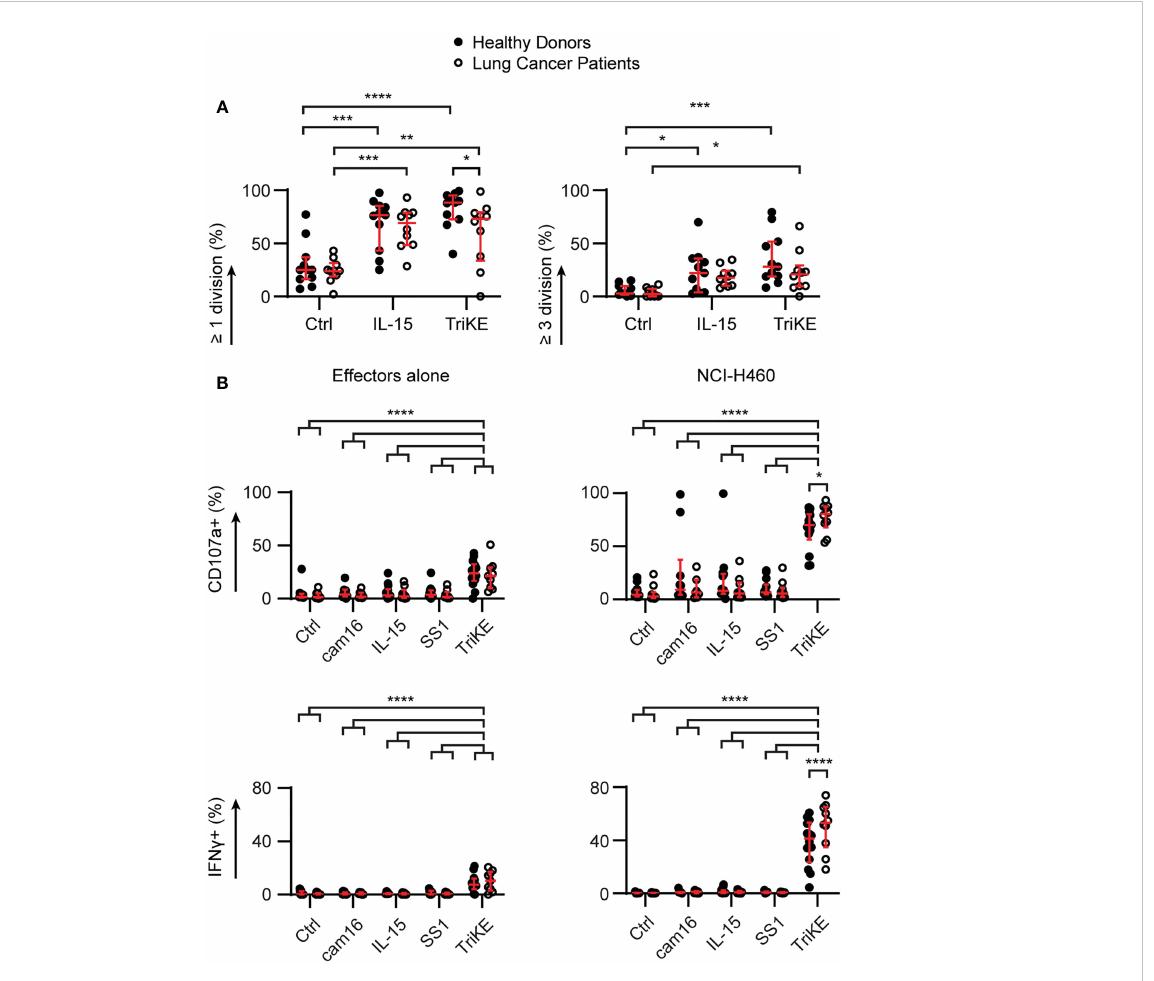
FIGURE 6 Cam1615SS1 promotes proliferation, cytokine production and degranulation of NK cells from both healthy donors and lung cancer patients. (A) PBMC were labelled with CellTrace Violet and cultured in media without drugs (Ctrl), with IL-15 or cam1615SS1 (TriKE) at 5nM. After 7 days, the proliferation (CellTrace dye dilution) of NK cells (CD56+ CD3-) was assessed by fl ow cytometry. Healthy donors (n=11) and lung cancer patients (n=10) were analyzed by Mixed effects analysis with Sidak ’ s multiple comparisons. (B) PBMC were cultured in the presence of the indicated drugs for 5 hours alone or in contact with lung cancer line NCI-H460. The amount of degranulation (CD107a+) and cytokine secretion (IFN g ) by NK cells (CD56+ CD3-) was assessed by fl ow cytometry; analyzed by mixed effects analysis with Sidak ’ s multiple comparisons. Healthy donors (cam16 n=10, all other conditions n=14); Lung cancer patients (cam16 n=7, all other conditions n=10). In all graphs, bars show median and interquartile range. * p<0.05, **p<0.01, *** p<0.001, ****